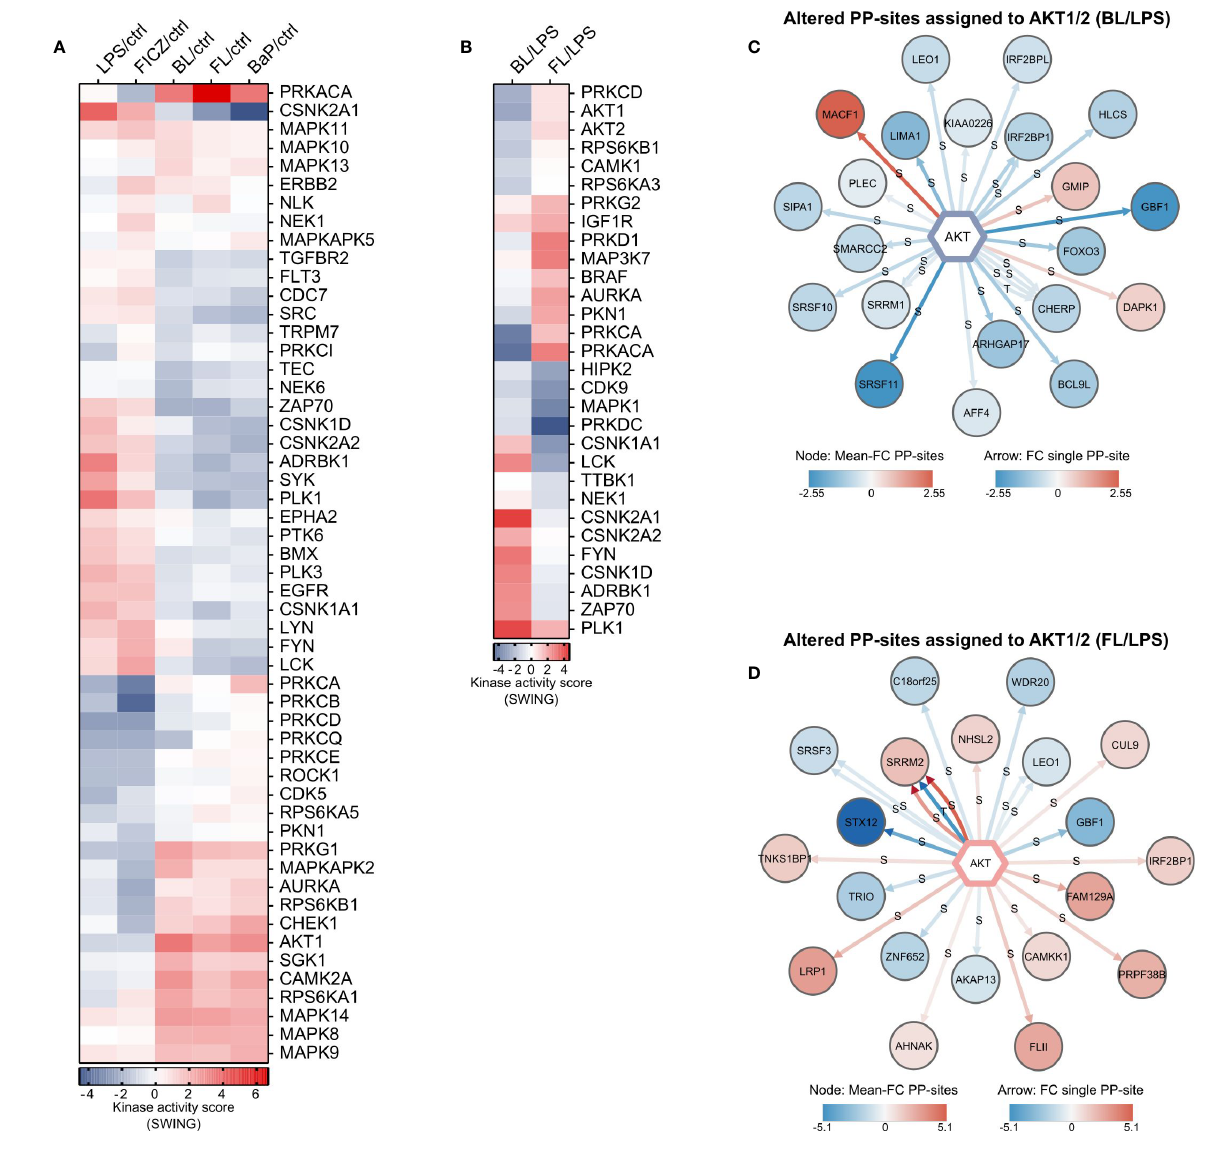
FIGURE 5 | Inferred kinase activities and substrates. (A) Inferred alterations in kinase activities responsible for altered PP-sites in comparison to untreated cells, and (B) altered PP-sites in BL- or FL-treated macrophages compared to LPS-treated cells. Kinase-substrate motifs were calculated based on the kinase-substrate dataset from PhosphoSitePlus. Relative kinase activity scores (SWING) were calculated by integrating amino acid sequence windows of signi fi cantly altered PP-sites with kinase-substrate motifs utilizing KinSwingR. Altered phosphorylations in BL- (C) and FL- (D) treated cells compared to LPS-treatment assigned to AKT1/2. Data on regulated PP-sites assigned to AKT serine/threonine kinase (AKT) isoforms 1 and 2 were extracted after sequence-motive assignment. Each arrow represents a single PP-site. The color of the kinase target represents the mean FC over all assigned